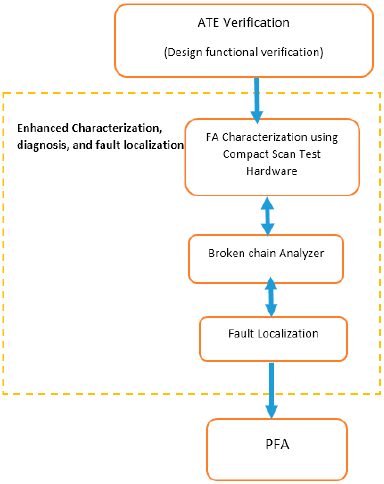
Figure 12. Failure analysis flow of digital failures using compact scan hardware and diagnosis tool sets.